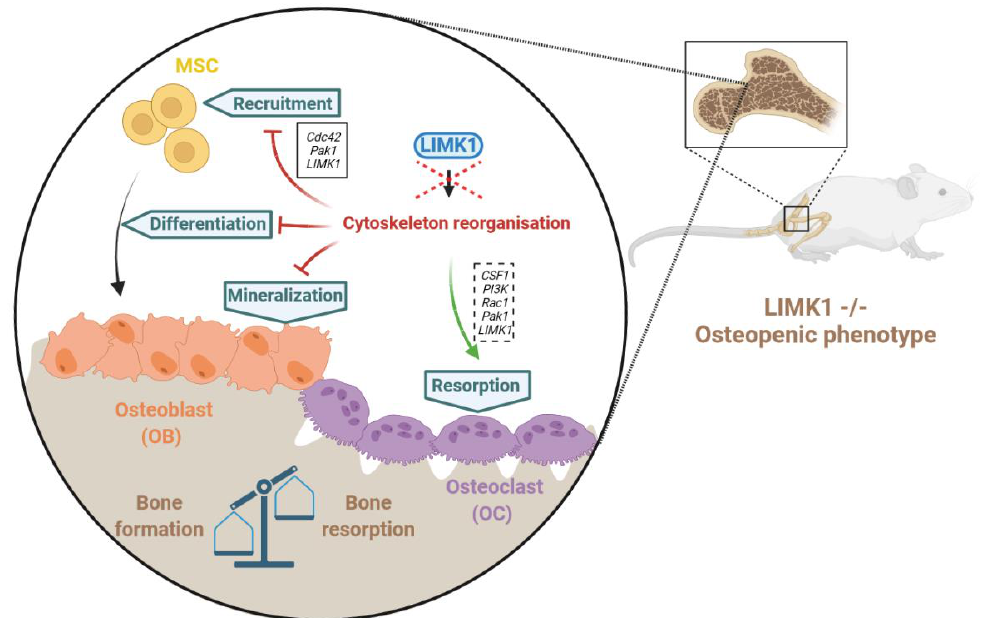
Figure 2. LIMKs and bone remodelling. Bone remodelling depends on a balance between bone for- mation and degradation. Osteoblasts, which derive from mesenchymal stem cells (MSC), participate in bone formation, while osteoclasts degrade bone. In physiological conditions, there is a balance between bone formation and bone degradation. In LIMK1 −/− mice, a disruption of this balance toward bone degradation has been observed. Black plain and discontinued outlines represent the confirmed or putative pathway, respectively.